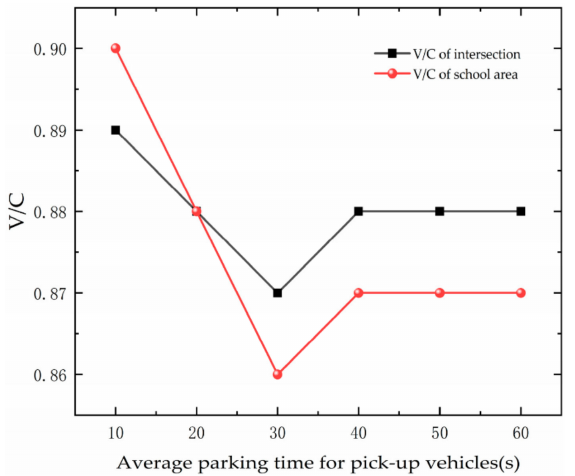
Figure 30. Variation trend of saturation with